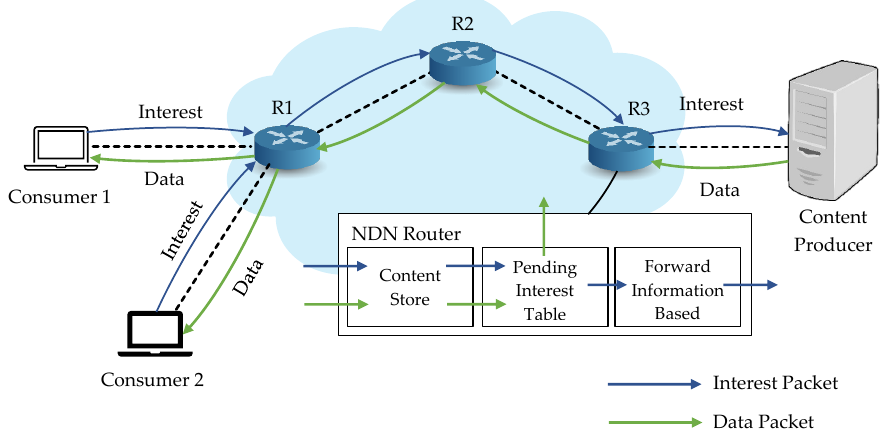
Figure 1. Fundamental architecture of